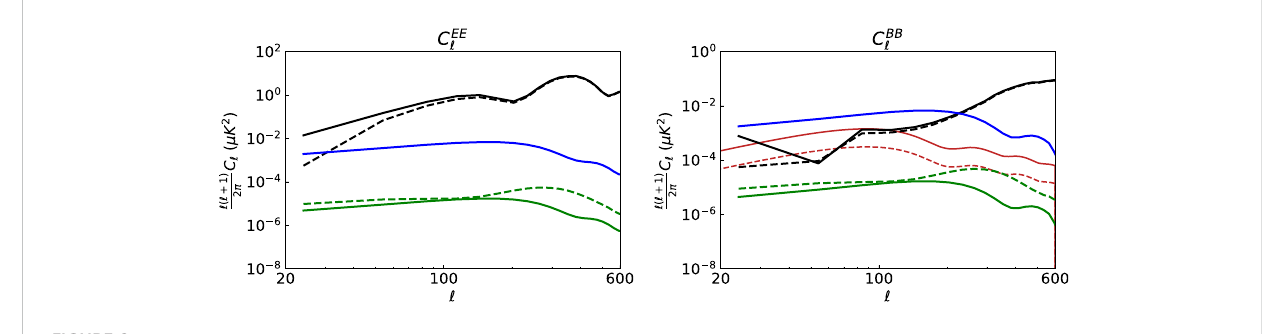
FIGURE 2 The EE and BB power spectra for the single point source simulation with given polarization direction and when r = 0.023, including the input (black solid) and fi ltered CMB (black dashed), residuals after the leakage removal with the ideal template (green solid) and the realistic template (green dashed), the true leakage (blue), and unlensed CMB BB spectra with r = 0.023 (red solid) and r = 0.005 (red dashed) as references. Note that the residual power spectra do not contain the contribution of the CMB.